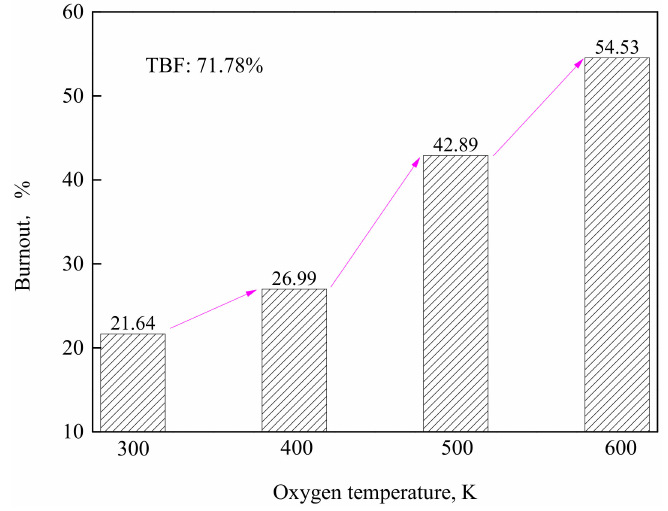
Figure 9. E ff ect of oxygen temperature on the final coal